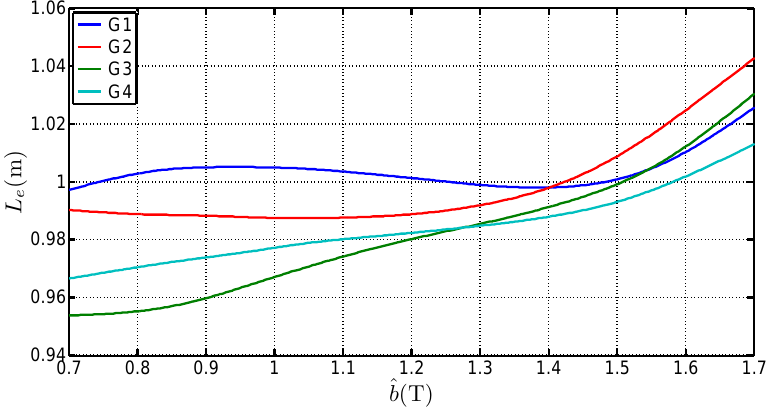
Figure 8. Variations of L e with ˆ b for four steel